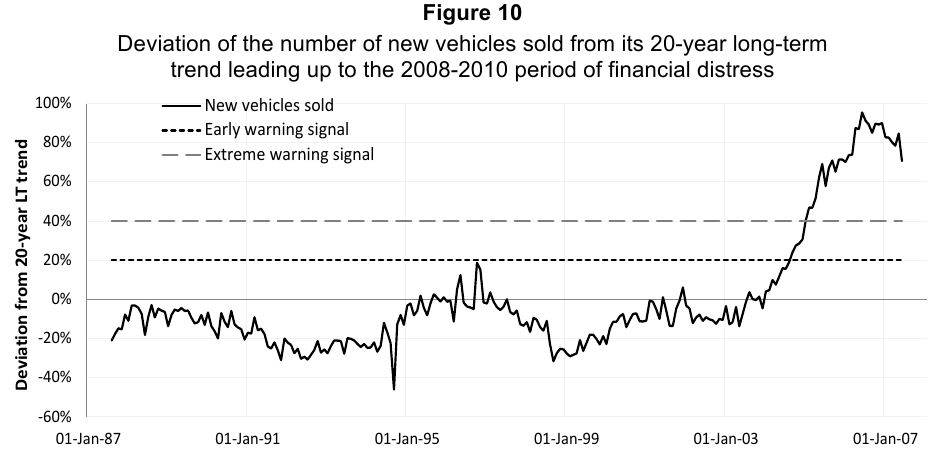
Deviation of the number of new vehicles sold from its 20-year long-term trend leading up to the 2008-2010 period of financial